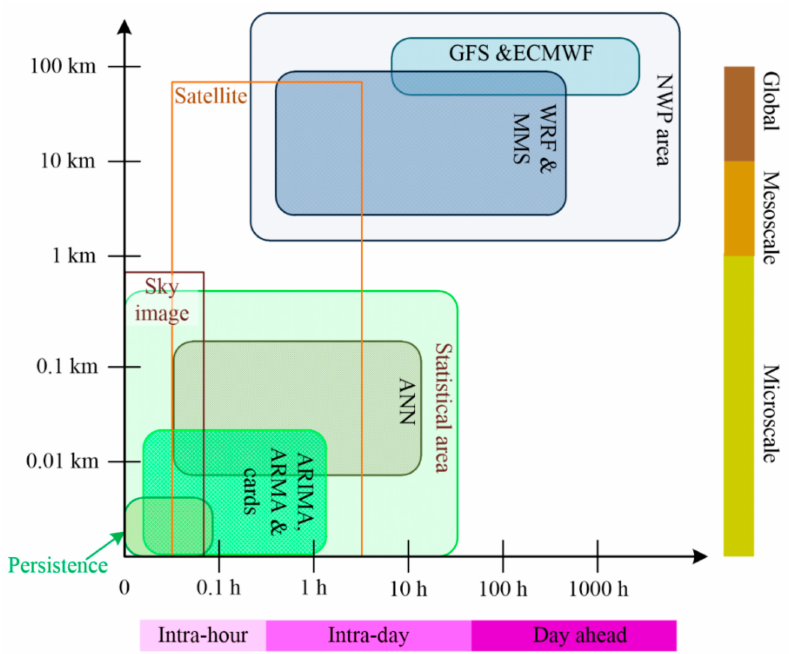
Figure 7. Temporal and spatial resolution for irradiance